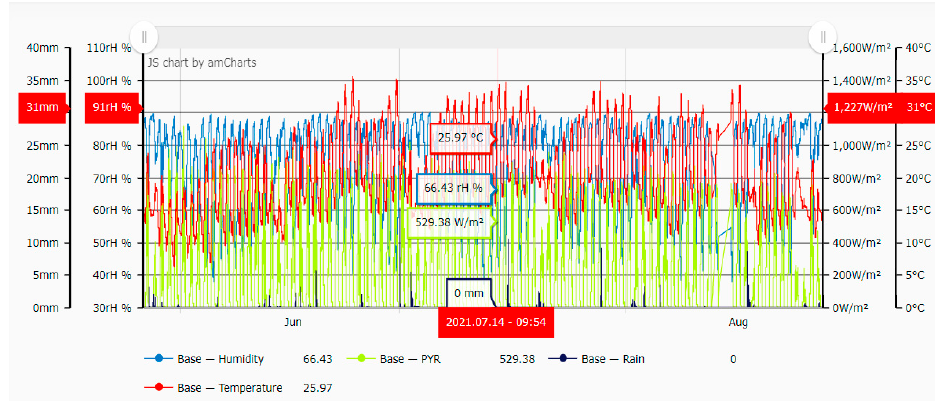
Figure 5. Microclimatological measurements from the experimental period for temperature, humidity, solar radiation, and rain values.